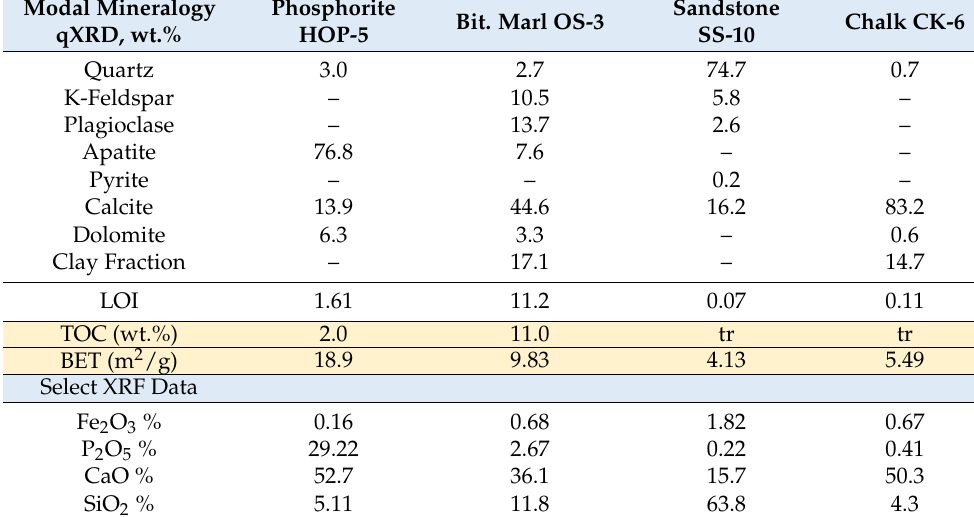
Table 3. Modal mineralogy and bulk major element chemistry of NE Negev lithologies, phosphorite, bituminous marl, sandstone, and chalk (500–2000 µ m size fraction), as determined by qXRD and XRF. TOC and BET measurements are also shown. [LOI: loss on emission; tr: trace (measured by EL-MS)]. Modal Mineralogy Phosphorite Sandstone Bit. Marl OS-3 Chalk CK-6 qXRD, wt.% HOP-5 SS-10 Quartz 3.0 K-Feldspar Plagioclase Apatite Pyrite Calcite 13.9 Dolomite 6.3 Clay Fraction